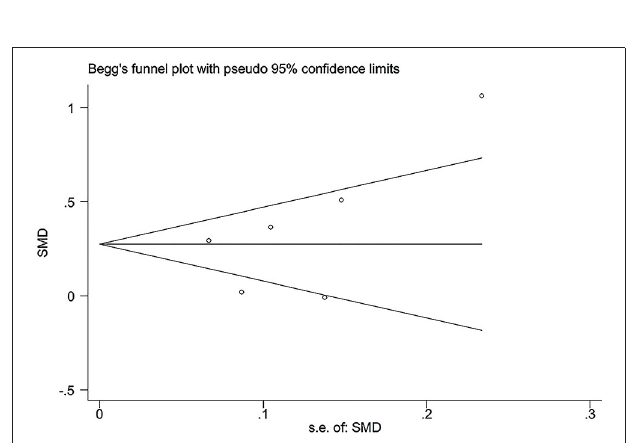
FIGURE 7 | Begg’s funnel plot of the association analysis between miRNA-146a rs2910164 polymorphism and plasma TG levels.